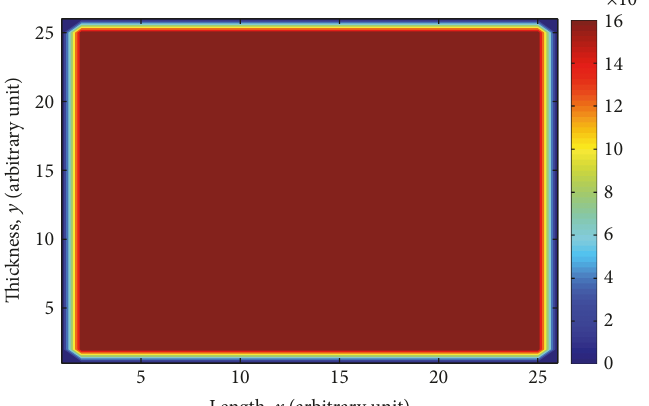
Figure 5: (Colored online) simulation illustrating the generation rate of charge carriers from a drift-di ff usion model of a BHJ OSC structure with planar contacts in two spatial dimensions.